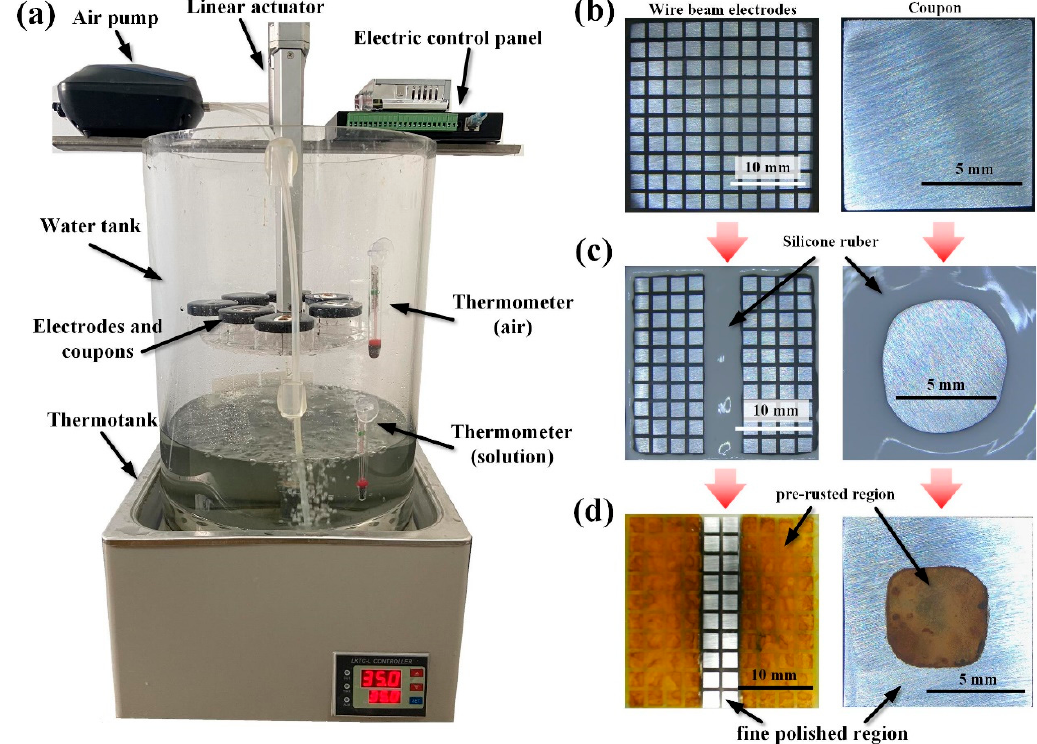
Figure 1. The test setup used for pre-rusting: ( a ) wet–dry circulation device for the pre-rusting process, ( b ) fine polished WBE and coupons, ( c ) partially coated WBE and coupons, ( d ) WBE and coupons after the pre-rusting process.